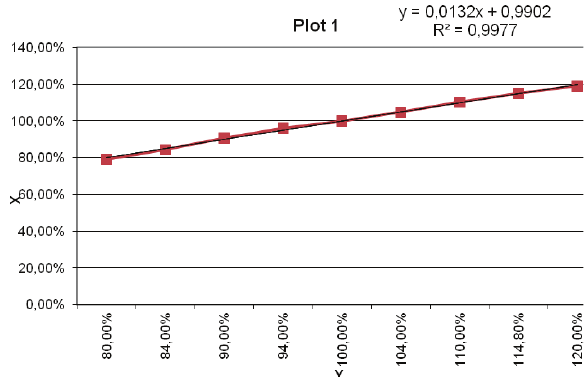
Figure 6. Linear dependence of the theoretical concentration of quinabut on the found concentration in normalized coordinates.